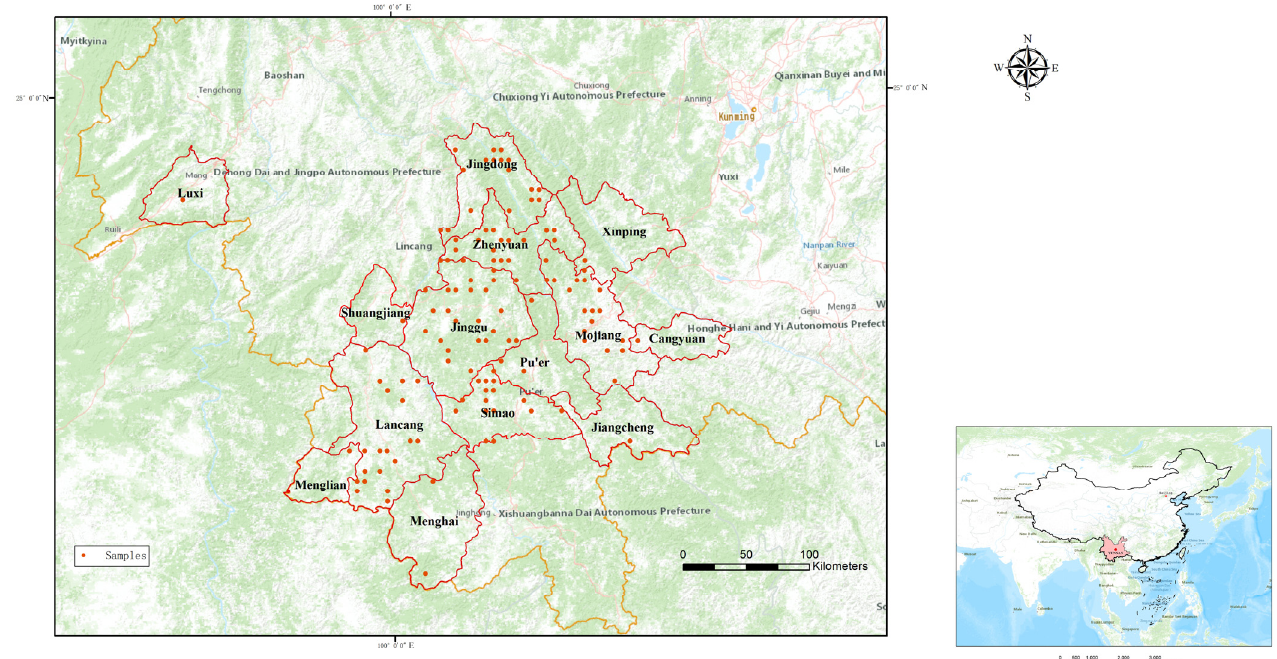
Figure 1. Sample plot distribution.